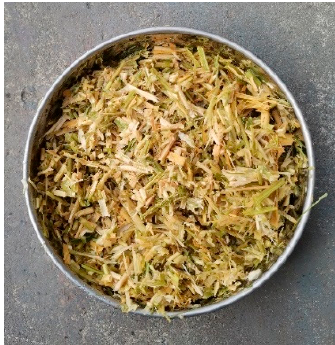
Figure 17. Straw after crushing. Table 5. Bench test